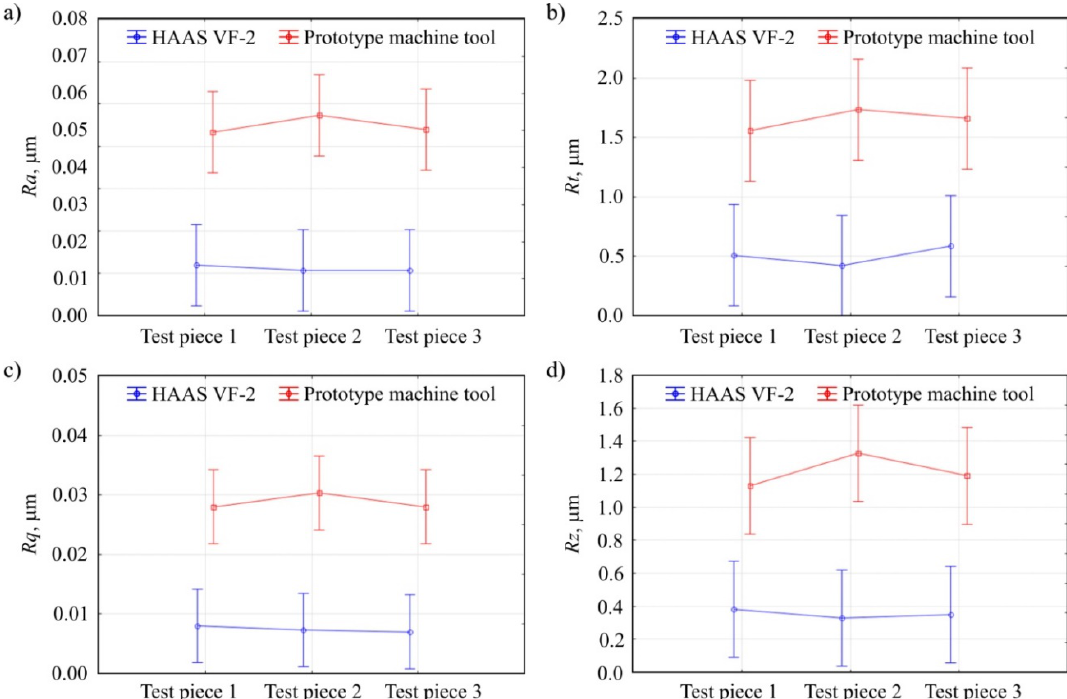
Figure 7. Comparison of the results of surface texture measurements of test pieces machined with the use of HAAS VF-2 milling center and prototype machine tool integrating 3D scanning, milling, and shaped grinding: ( a ) arithmetical mean deviation of the roughness profile Ra ; ( b ) total height of the profile within a sampling length Rt ; ( c ) root mean square deviation of the roughness profile Rq ; ( d ) maximum height of the profile within a sampling length Rz (vertical bars present 0.95 confidence intervals, number of measurement repetitions n = 3).